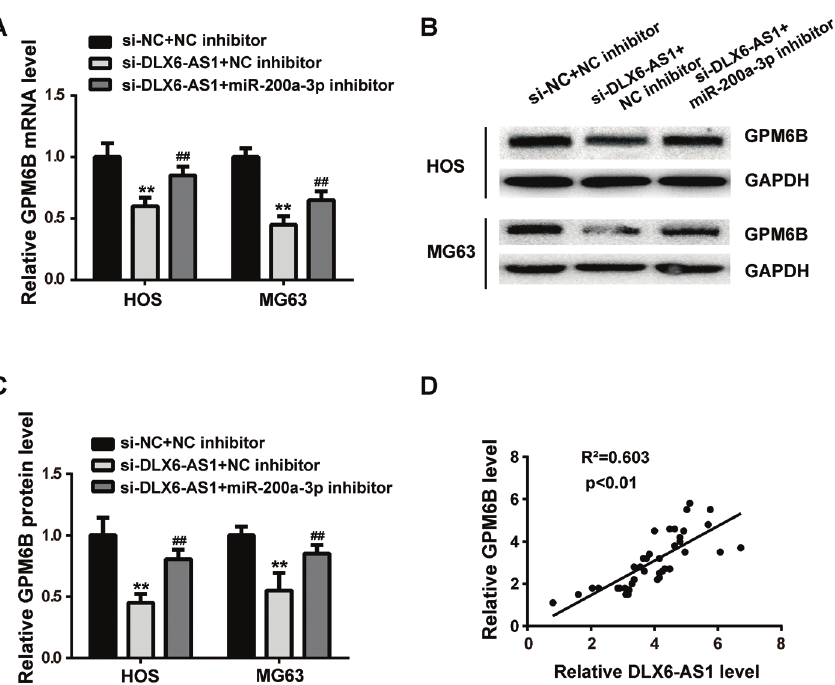
Fig. 6. DLX6-AS1 positively regulated GPM6B via sponging miR-200a. (a) Under si-DLX6-AS1 transfection with miR-200a-3p inhibitor or NC inhibitor, the mRNA expression of GPM6B was detected by qPCR. (b, c) Under si-DLX6-AS1 transfection with miR-200a-3p inhibitor or NC inhibitor, GPM6B protein expression was detected by qPCR. (d) DLX6-AS1 had a positive correla- tion with GPM6B. NC, negative control. ** P < 0.01, versus si-NC+NC inhibitor; ##<0.01, versus si-DLX6-AS1+NC inhibitor.